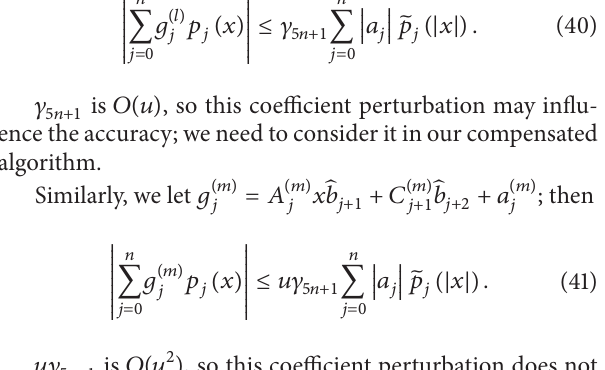
Algorithm 10: Addition of a double-double number and a double- double number.